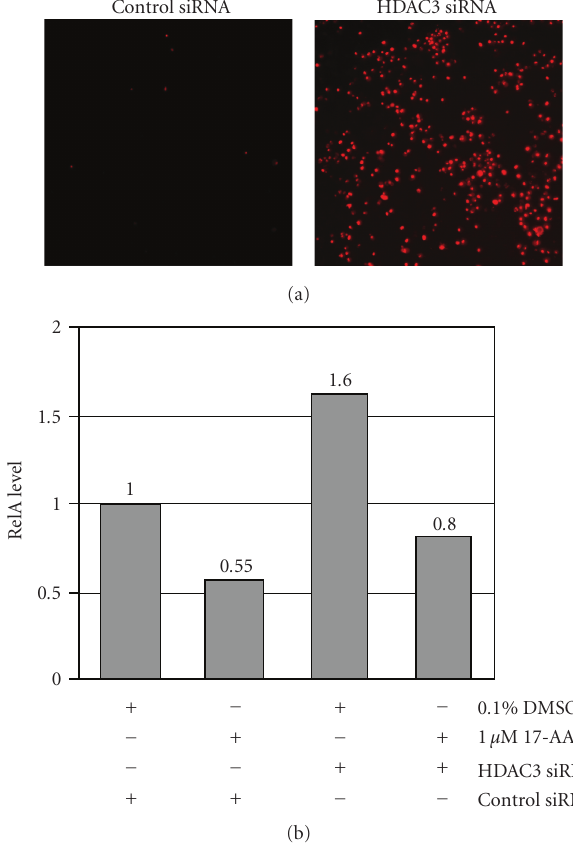
Figure 5: HDAC3 siRNA knockdown recapitulates the e ff ects HDAC inhibitors on synovial sarcoma cells . (a) 50 nM HDAC3 siRNA promotes extensive cell death at 24 hours, as shown by staining of a large inviable cell fraction by 500ng/mL propidium iodide, where virtually all cells exposed to equimolar scrambled siRNA control are viable. (b) Densitometric quantitation of Western blots for nuclear RelA, expressed relative to control siRNA transfected cells treated with vehicle (1.0). Table 2: Combination of HDAC and NF- κ B inhibitors against synovial sarcoma